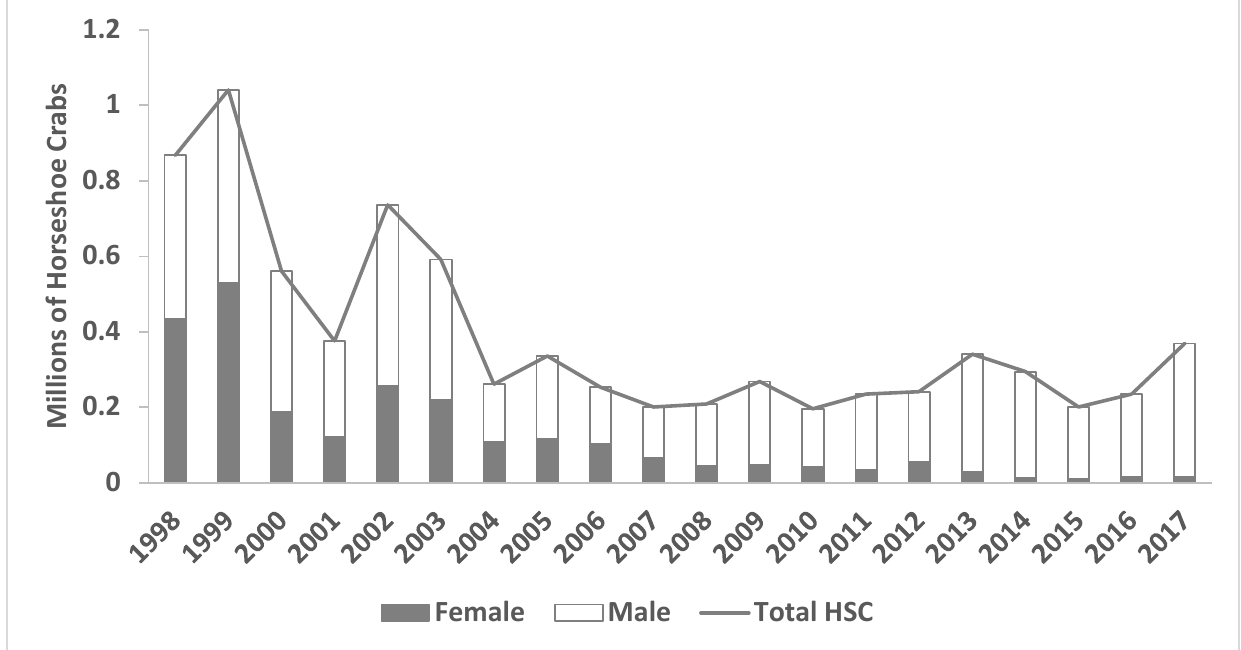
Figure 5. Horseshoe crab bait landings of Delaware Bay origin, 1998-2017, by sex to support the catch multiple survey model. All landings were validated through ACCSP.